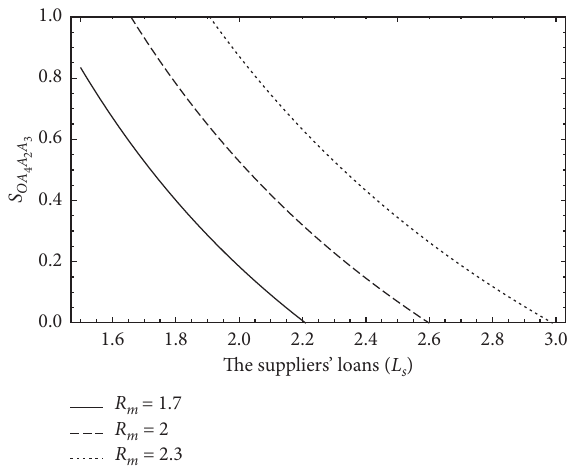
Figure 5: The impacts of the bank loan rate on S various financial risk factors.